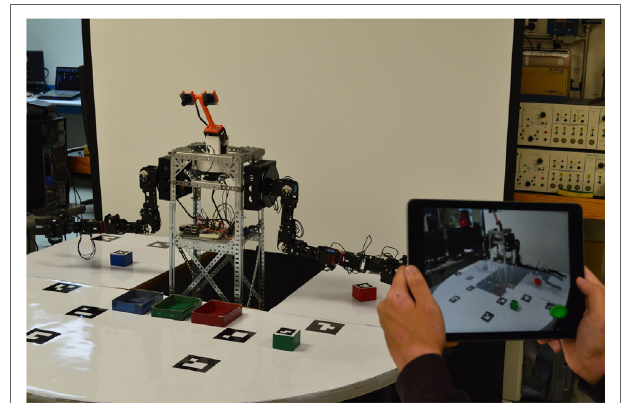
FigUre 1 | The environment used to conduct the human–robot interaction study .